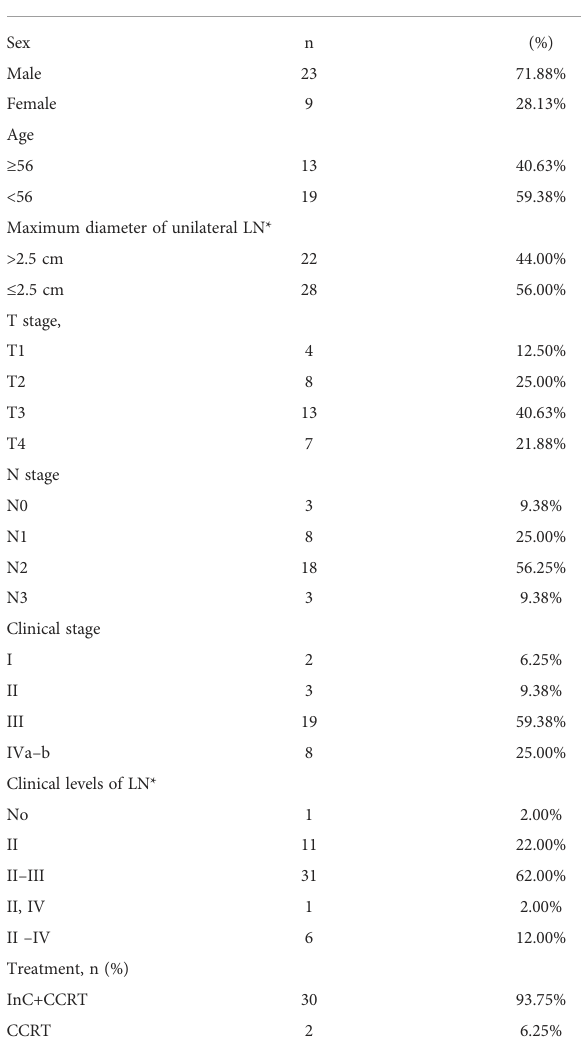
TABLE 1 Clinicopathological